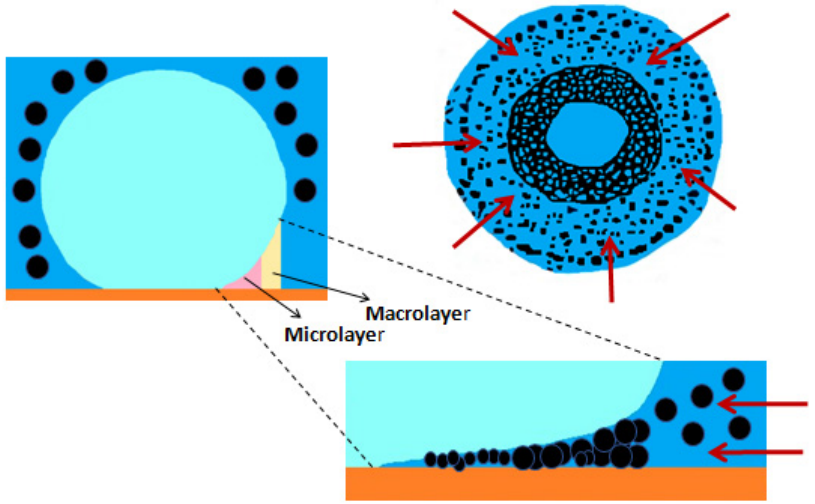
Figure 6. Schematic illustration of the nanoparticle deposition process and top view of the depos- structure showing the size distribution of the ited structure showing the size distribution of the nanoparticles.